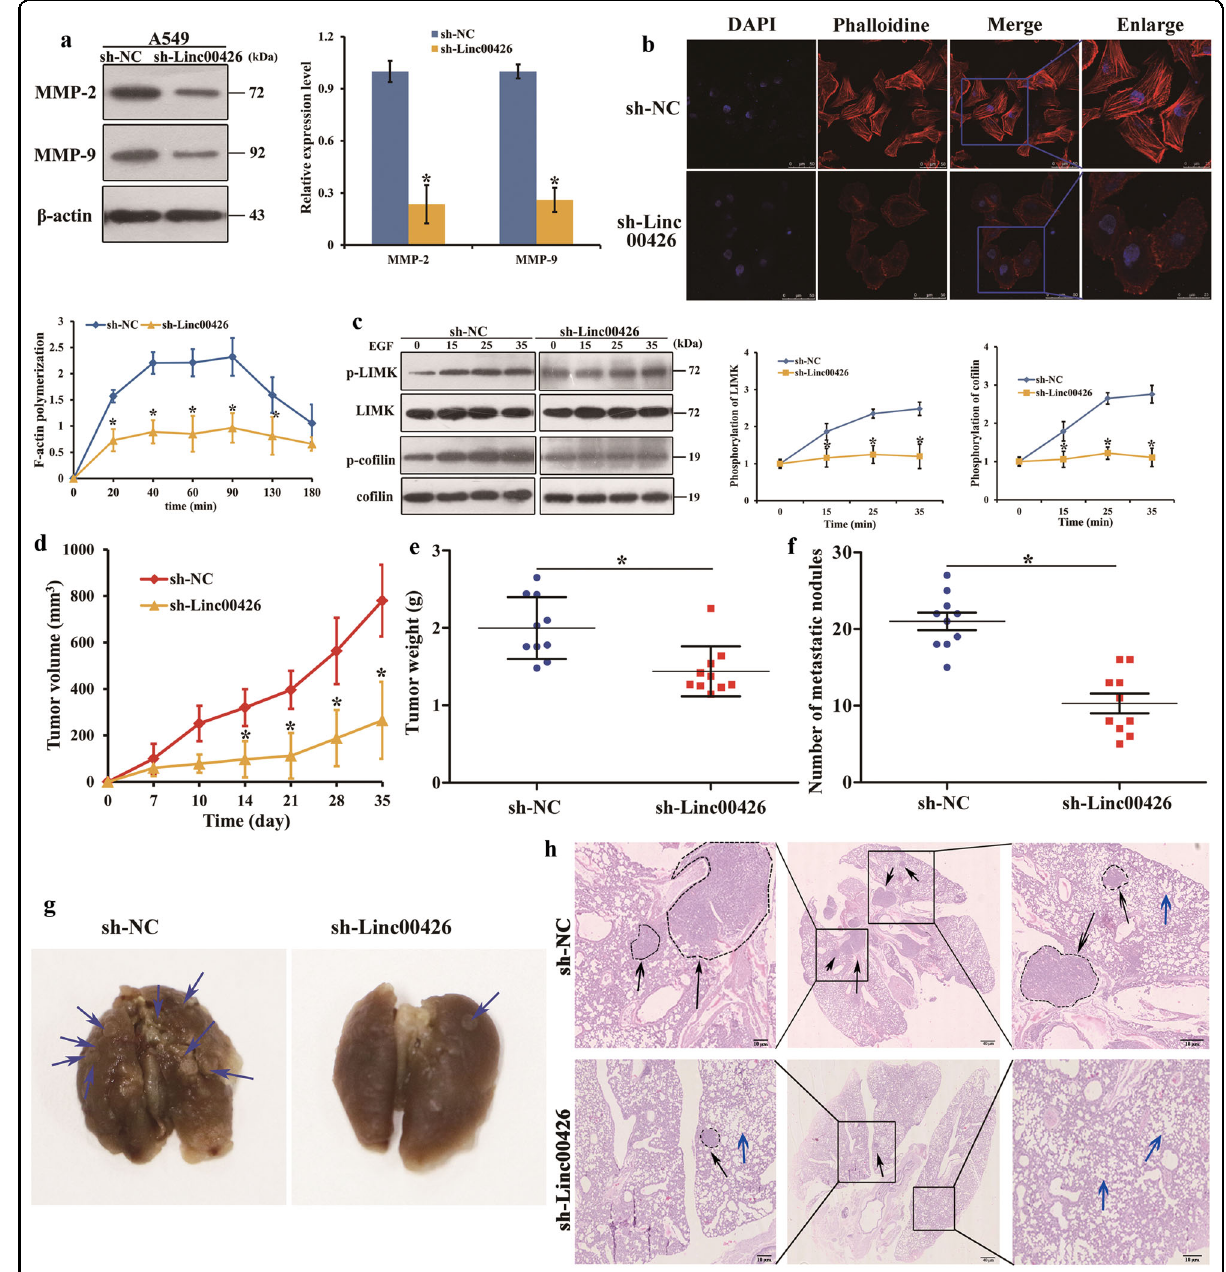
Fig. 3 Linc00426 is required for cytoskeleton rearrangement and matrix metalloproteinase expression and downregulation of Linc00426 represses tumor growth and metastasis of LUAD in vivo. a The expression of MMP-2 and MMP-9 in A549 cells with sh-NC and sh-Linc00426. b Images of F-actin (red) and nucleus (blue) staining in A549 cells with sh-NC and sh-Linc00426. The chart shows F-actin polymerization in A549 cells with sh-NC and sh-Linc00426. Scale bar = 50 μ m. c The expression of p-LIMK and p-co fi lin in A549 cells with sh-NC and sh-Linc00426. d Growth curves of A549 cells with sh-NC and sh-Linc00426 derive from subcutaneous tumor xenografts. Tumor volume is measured with time duration. e Tumor weight is measured after surgical dissection. f Number of metastatic nodules in different tissue slices. g Bright- fi eld imaging (arrows indicate metastases) and counting of metastatic nodules. h H&E staining and number of metastatic foci in the lungs injected with sh-NC and sh-Linc00426 cells. The metastatic focus is indicated with dotted line and black arrows; The alveolar is indicated with blue arrows. Scale bar = 40 μ m and 10 μ m. * P < 0.05. Student ’ s t